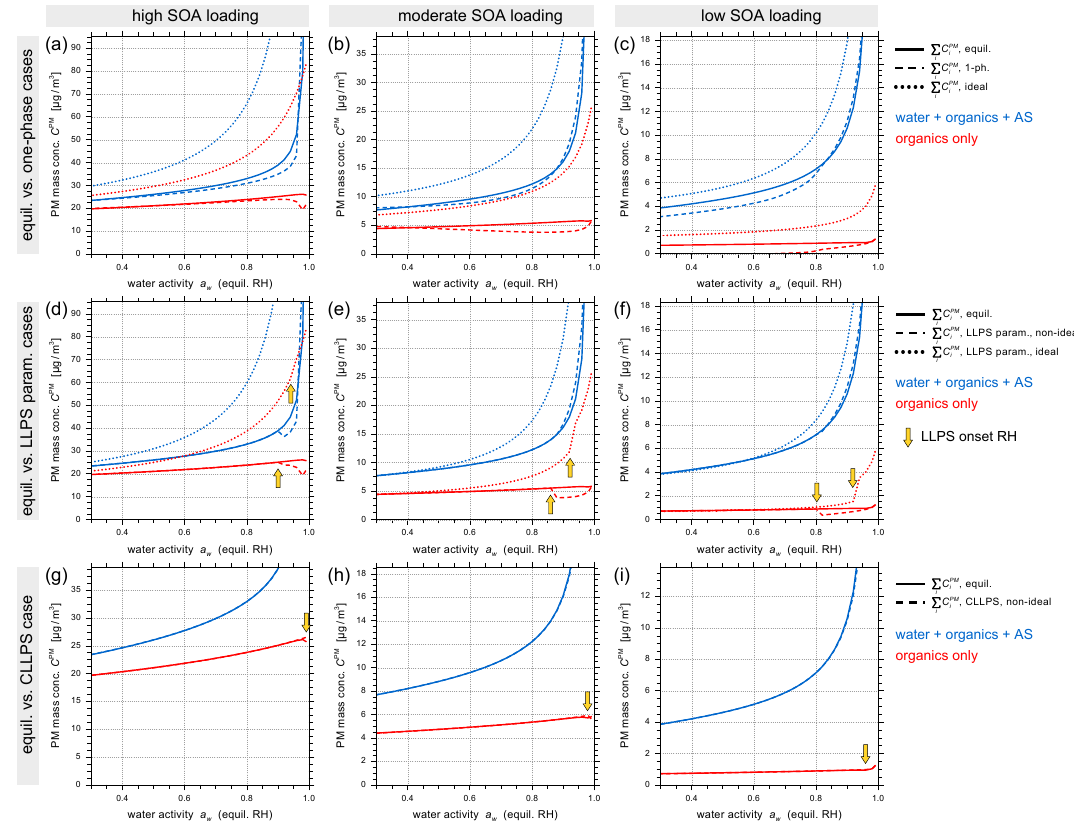
Fig. 5. Total particulate matter (PM) concentrations (blue curves) and total organic PM concentrations (organic PM fraction; red curves) plotted as a function of RH at 298K. The different modeling cases are compared with the benchmark (equil.) case at three distinct SOA loading levels. Top row (a, b, c) : comparison of the forced one-phase case (1-ph., dashed curves) and the ideal mixing case (dotted curves) with the equil. case (solid curves in all panels). Middle row (d, e, f) : comparison of the non-ideal (dashed curves) and ideal (dotted curves) LLPS param. cases with the benchmark case. The phase separation onset RH is calculated using the parameterization of Bertram et al. (2011). The yellow arrows mark the calculated upper RH limit of liquid-liquid phase separation for the parameterized cases (responsible for the kinks in the curves). Bottom row (g, h, i) : comparison of the complete phase separation CLLPS case with the benchmark case. AIOMFAC is used to compute activity coefficients in all cases where non-ideal mixing is